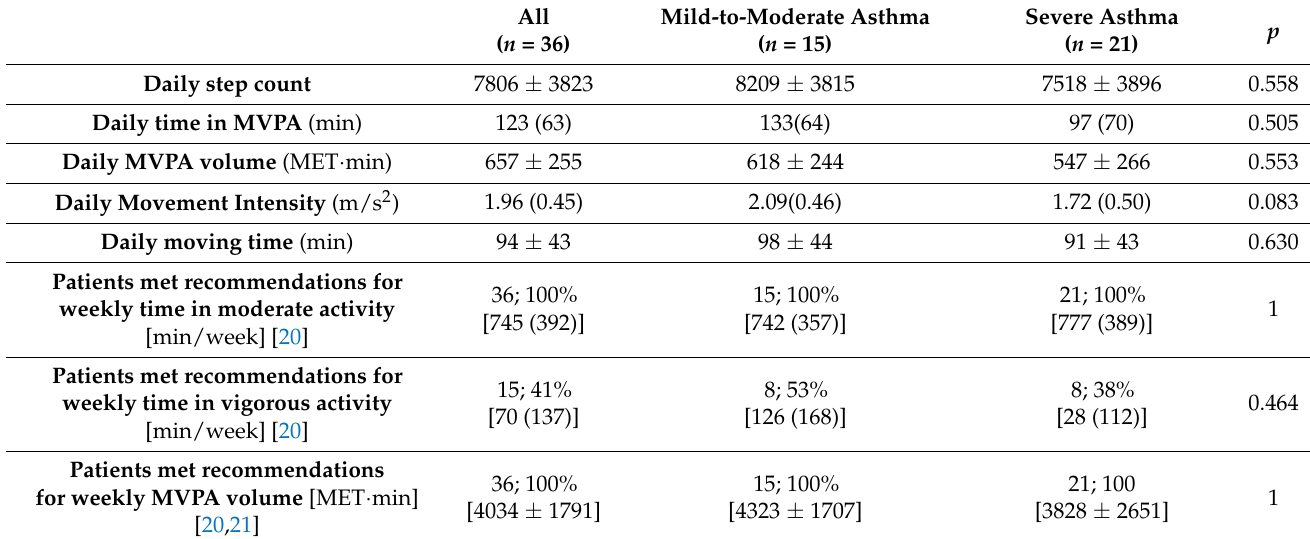
Table 2. Daily physical activity and comparison against current